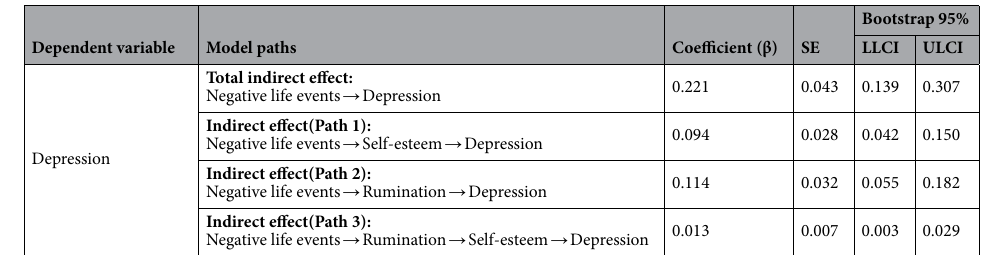
Table 2. Summary of path coefficients and mediating effects